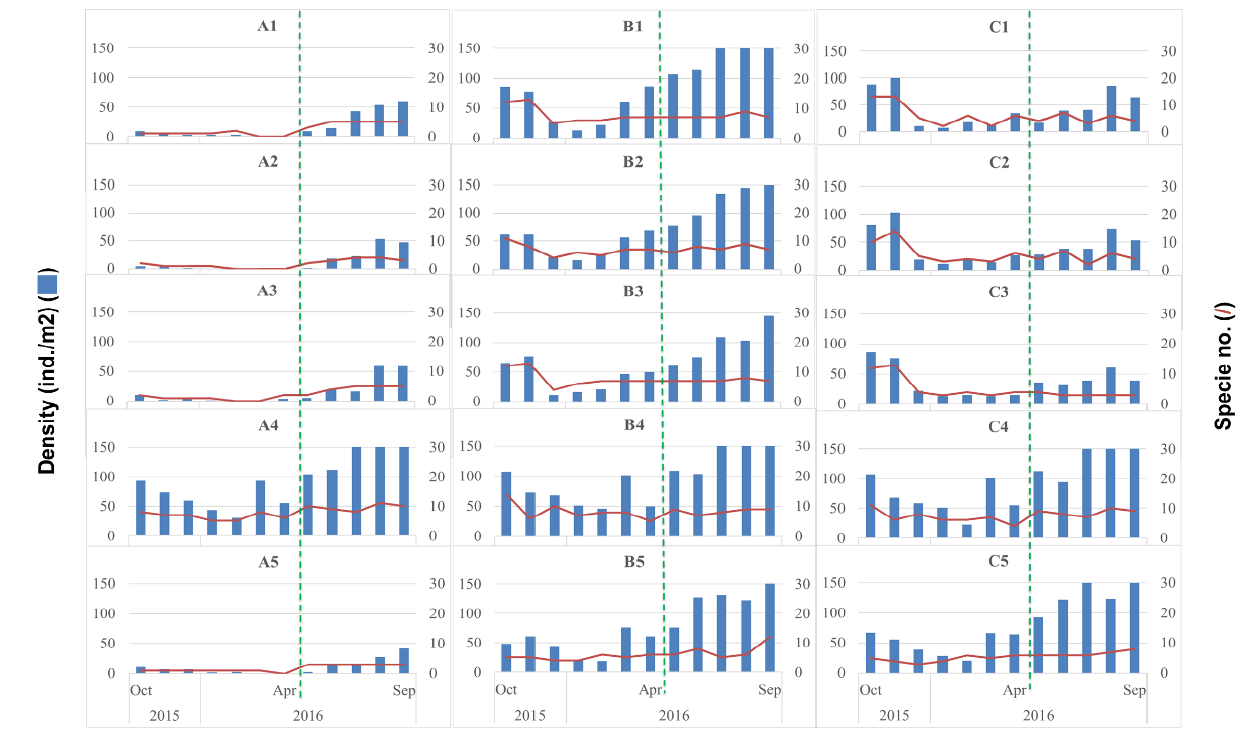
Figure 2. Fluctuations in density and number of crab species over the survey period.